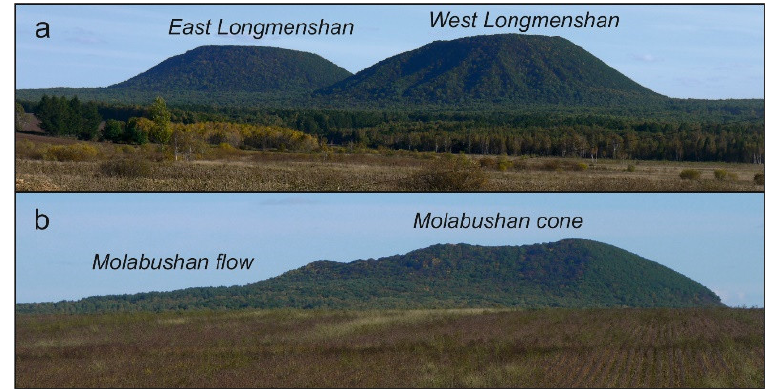
Figure 3. Photos of the volcanoes: ( a ) Longmenshan (view from the north), ( b ) Molabushan (view from the west).